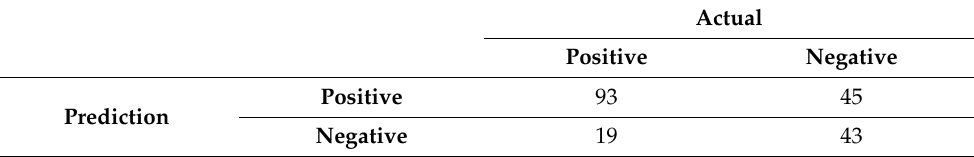
Table 11. Confusion matrix for “medium” level occupancy.